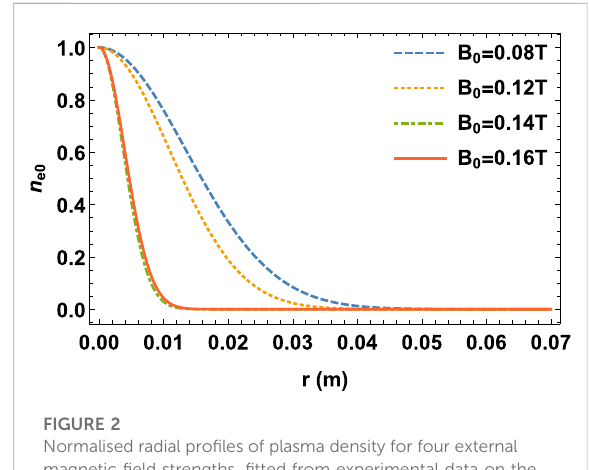
FIGURE 2 Normalised radial pro fi les of plasma density for four external magnetic fi eld strengths, fi tted from experimental data on the CSDX [9,